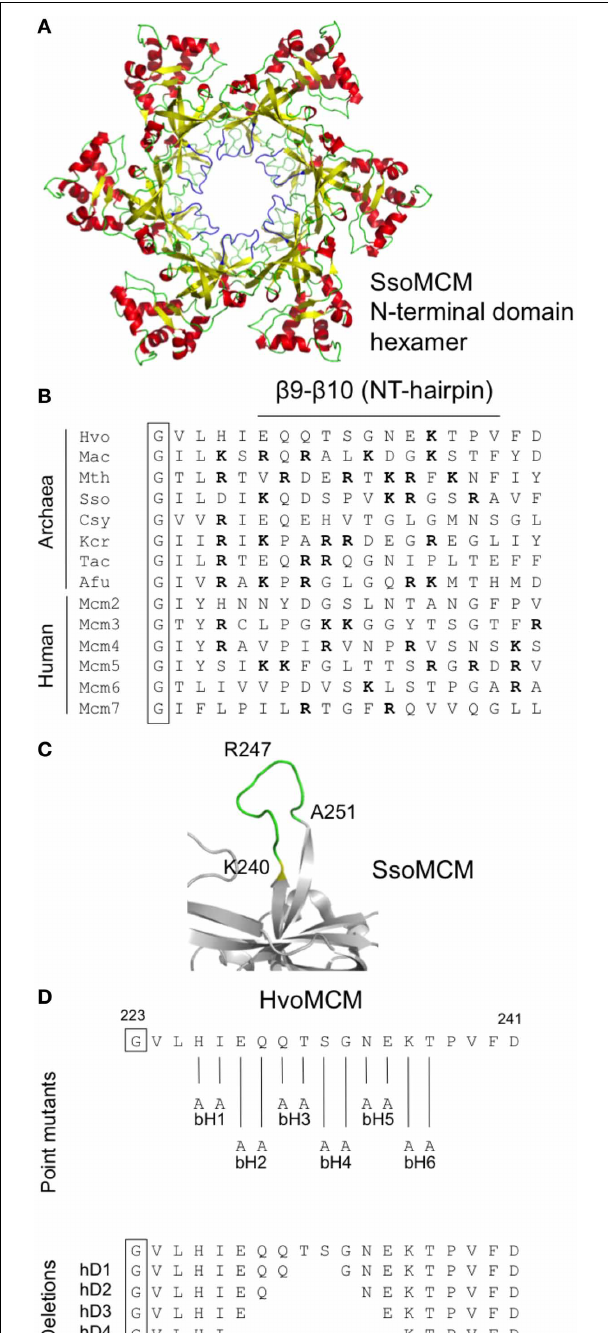
FIGURE 5 | Mutagenesis of the β 9- β 10 β -hairpin (NT-hairpin). (A) Structure of the S. solfataricus MCM N-terminal domain hexamer (PDB 2VL6) with the β 9- β 10 β -hairpins highlighted in blue. (B) Multiple sequence alignment of the β 9- β 10 β -hairpin region from diverse archaeal species and from human (see legend to Figure 3 for key and Table 1 for strain details and protein accession numbers). Basic amino acids are highlighted in bold type. (C) Close-up of S. solfataricus MCM β 9- β 10 hairpin loop. (D) Location and nature of intended mutations in Hfx. volcanii MCM protein. Attempts were made to construct six paired alanine substitutions (bH1–6) and four short deletions (hD1–4). See text for